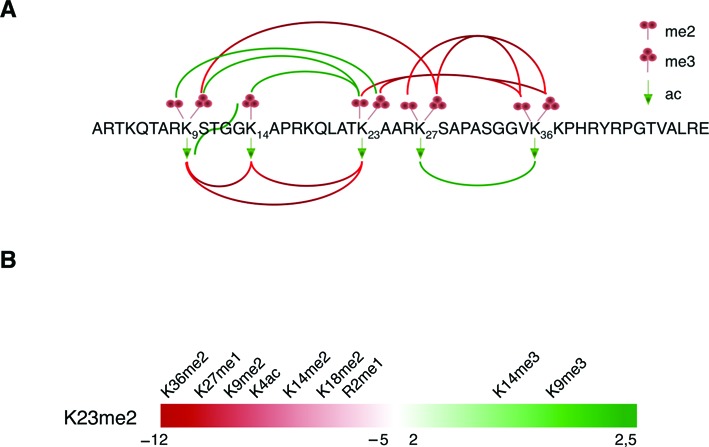
Histone H3 cross-talk. (A) Cartoon of histone H3 N-terminal tail (aa 1–50) and the experimentally and computationally determined interplay between lysine di-, tri-methylations and acetylations. Green and red lines represent positive and negative interplays, respectively. For clarity, the image displays only the most pronounced interplay values. (B) Interplay values of binary marks from H3K23me2 perspective. Major interplay values are represented as negative score (red) = rarely together on the same tail, positive score (green) = frequently together on the same tail.